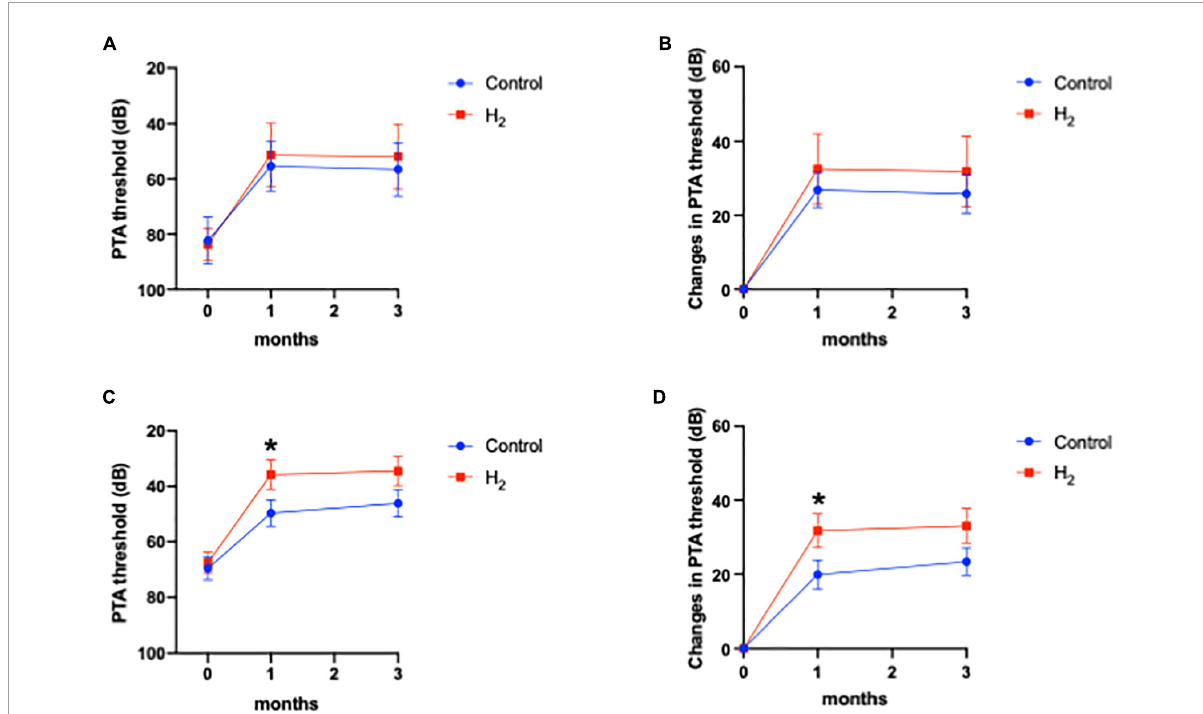
FIGURE8 Hearing outcomes depending on hyperlipidemia. (A) PTA threshold among patients with hyperlipidemia. (B) Changes in the PTA threshold among patients with hyperlipidemia. (C) PTA threshold among patients without hyperlipidemia. (D) Changes in the PTA threshold among patients without hyperlipidemia. The effect of H 2 was not observed in patients with hyperlipidemia. Hearing outcomes were significantly better in the H 2 group 1 month after treatment than in the control group among patients without hyperlipidemia; however, these significant differences disappeared 3 months after treatment. * P <